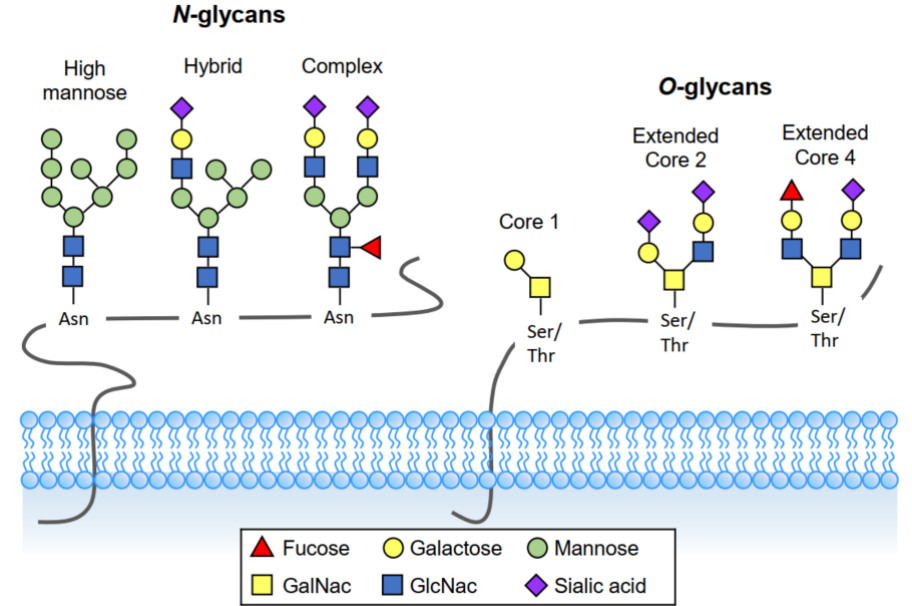
Figure 1. Two major types of protein glycosylation. N -glycans consist of N-acetylglucosamine (GlcNAc) attached by a β1 -glycosidic linkage to the amino group of asparagine (Asn). Mucin-type O -glycosylation, consisting of O -glycans attachment via O -linked Nacetylgalactosamine (GalNAc) to the hydroxyl oxygen of serine/threonine (Ser/Thr) residues.